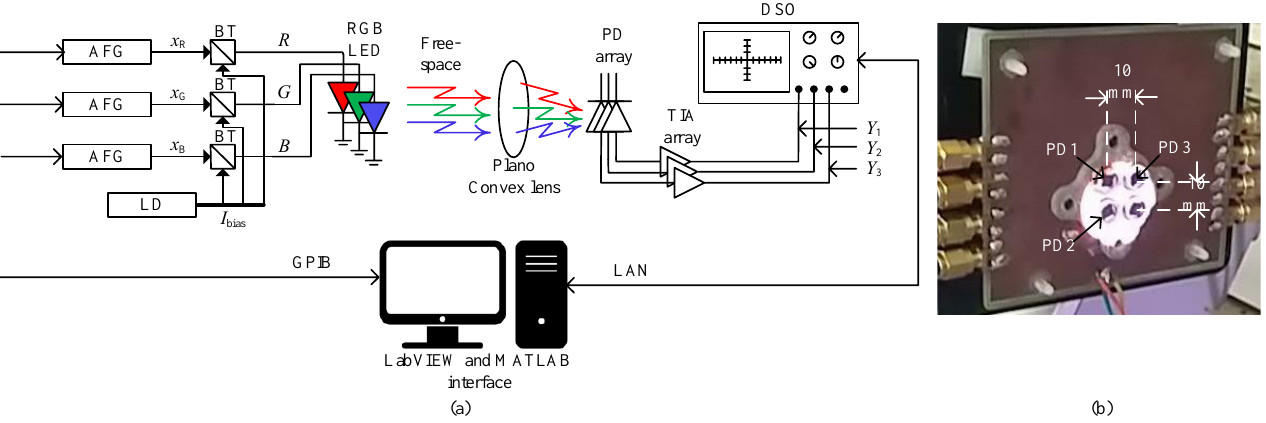
Figure 1. ( a ) Defocused MIMO system block diagram. BT: bias tee, LD: laser driver, and ( b ) photograph of the defocused beam on the PD array.